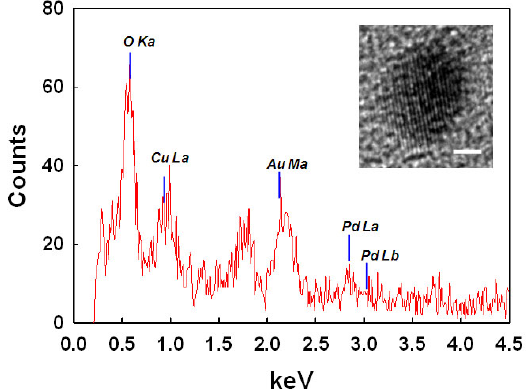
Figure 4. EDX spectrum and HRTEM (inset) for the AuPdNPs @ TOCN composite, with a molar ratio of Au:Pd = 3:1. Scale bar corresponds to 2 nm.